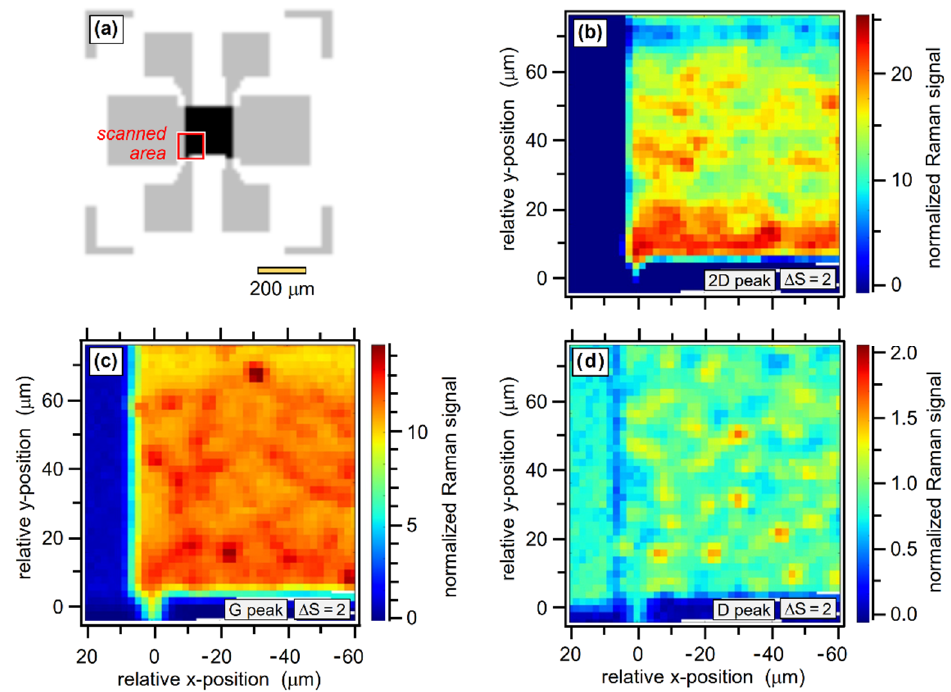
Figure 5. Raman image maps of a GFET device (200 × 200 μm 2 , Graphenea ). ( a ) Schematic GFET structure; the area scanned by CRM—about 80 × 80 μm 2 —is indicated by the red square; the spatial reference point for the scans is the left-most contact. ( b – d ) Maps of the 2D-, G- and D-peak signal, respectively, scanned with a step increment of ∆ S = 2. Note that 1 step-increment ( ∆ S = 1) corresponds to a spatial displacement of ~1.25 μm. For further details, see text.